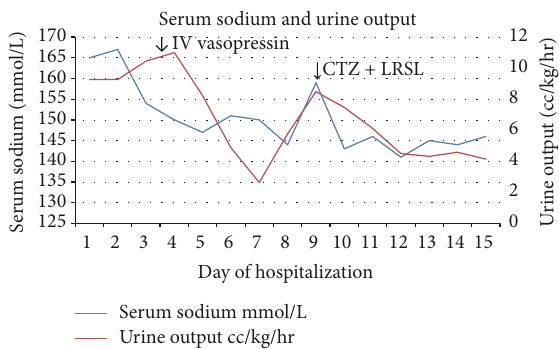
Figure 1: Serum sodium levels and urine output during hospitaliza- tion. CTZ: chlorothiazide; LRSL: low renal solute load